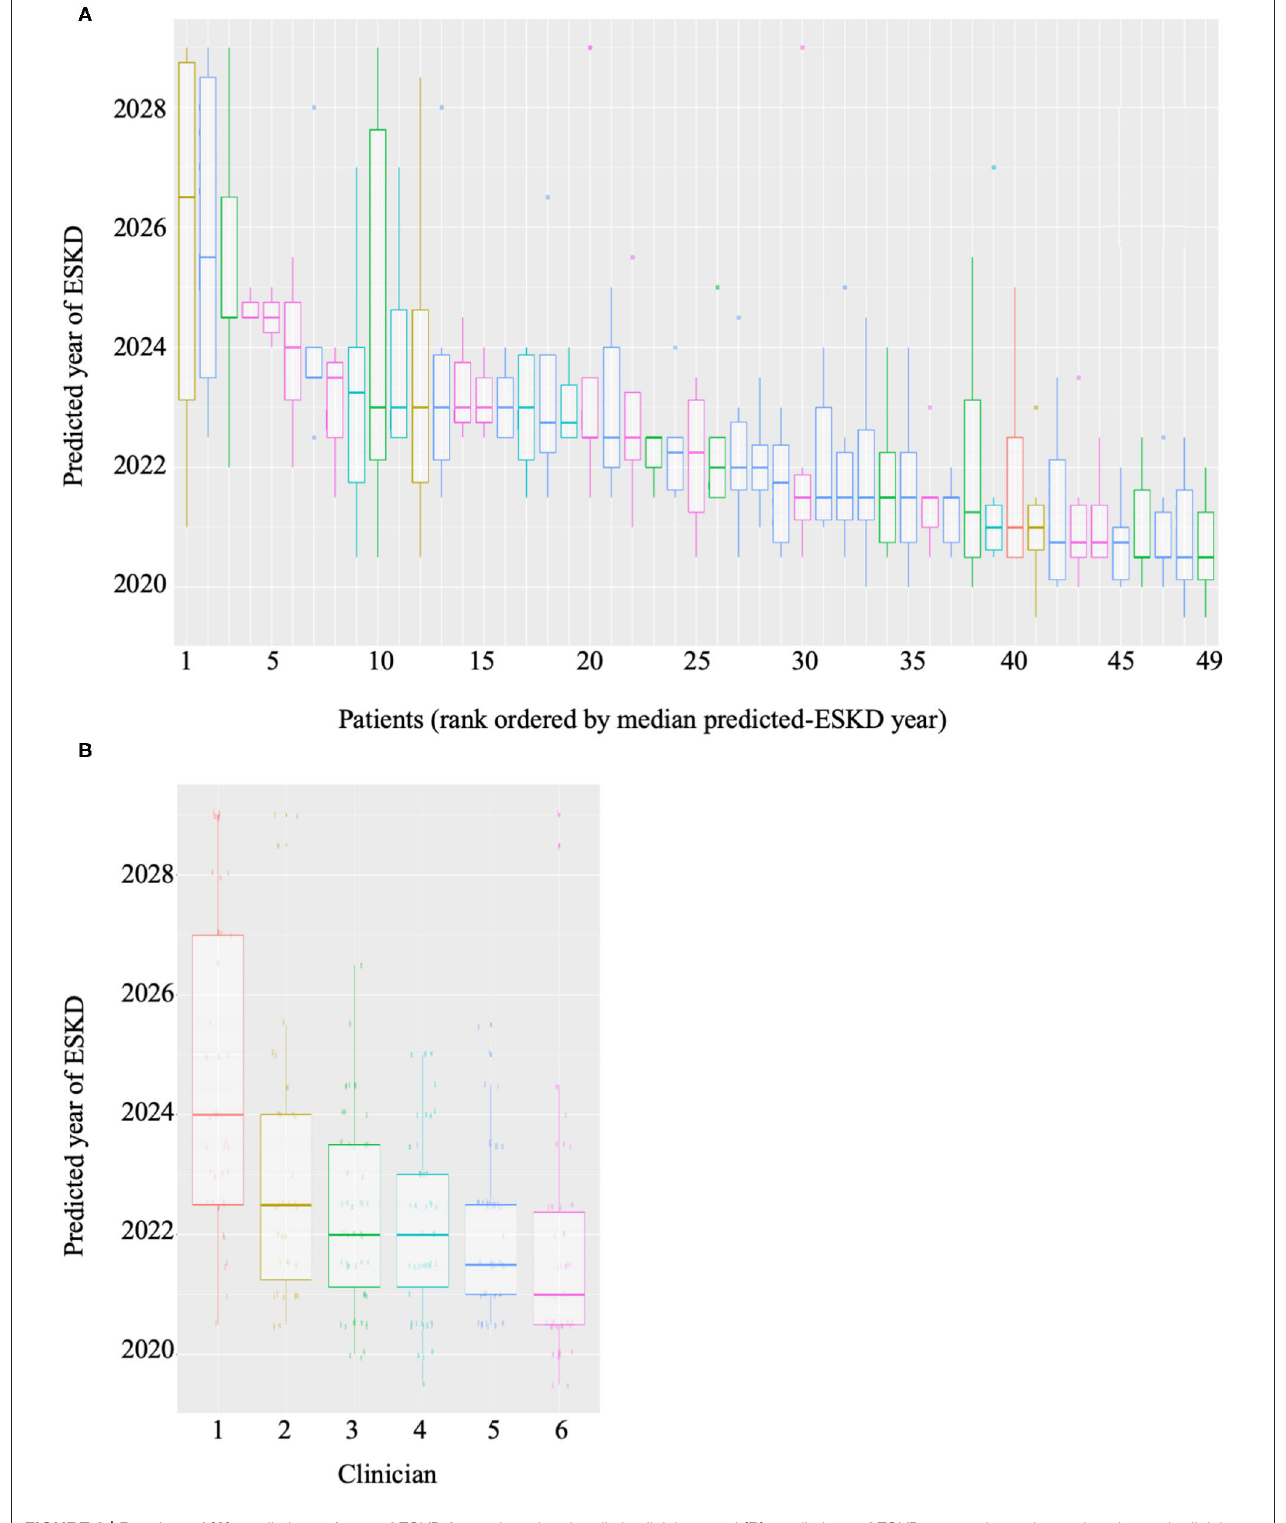
FIGURE 2 | Boxplots of (A) predictions of year of ESKD for each patient by all six clinicians and (B) predictions of ESKD across the patient cohort by each clinician.